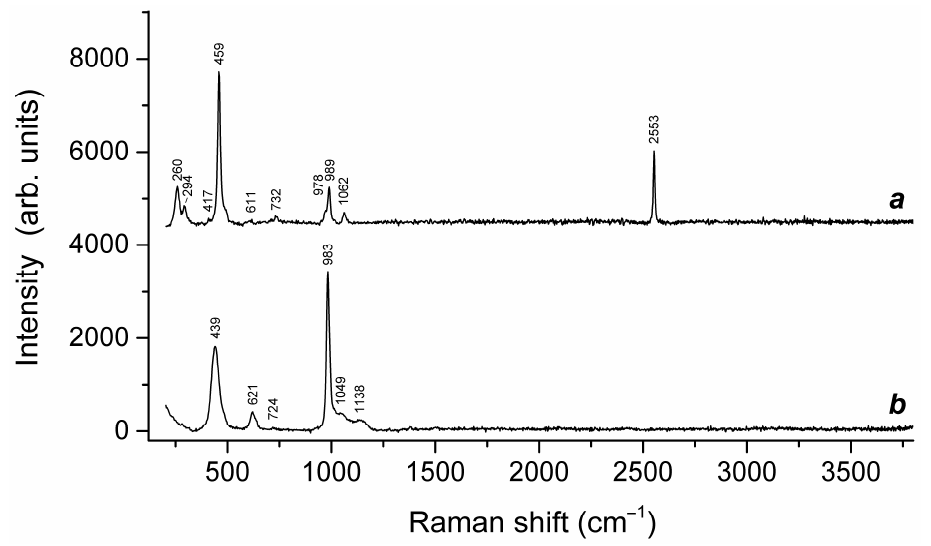
Figure 3. Raman spectra of ( a ) sapozhnikovite (Sample 8) and ( b ) nosean (Sample 7). Table 2. Assignment of Raman bands of cubic sodalite-group The assignment of bands in the Raman spectra of cubic sodalite-group minerals